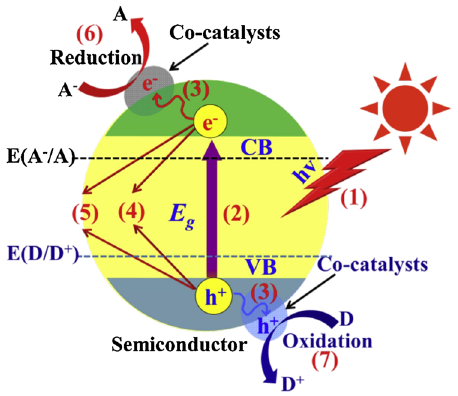
Figure 2: The fundamental mechanism of